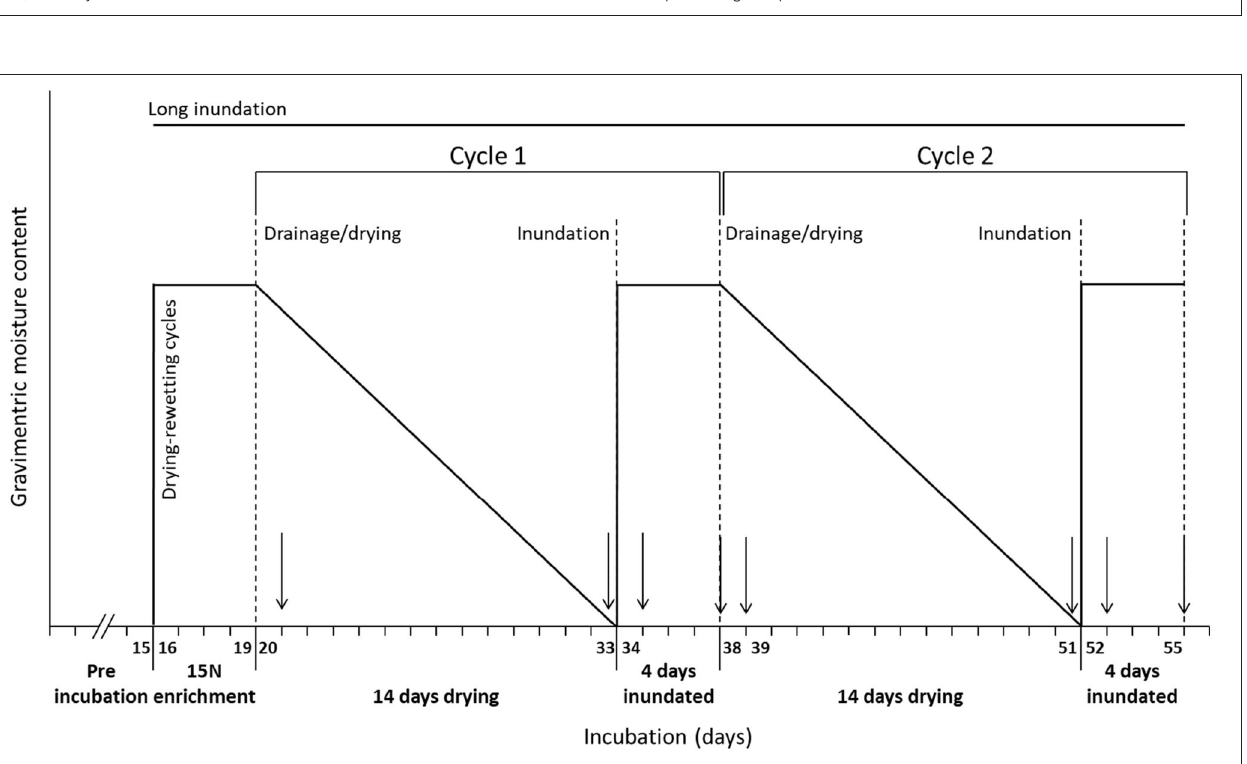
FIGURE 1 | Mesocosm apparatus. Each mesocosms consisted of one fixed part and one removable part. The fixed part consisted of a cylinder (h = 485mm, outer/inner d = 150/142mm; A) attached to an open plate at the top (d = 210mm, t = 20mm; B) and to a perforated plate at the bottom (d = 210mm, t = 12mm; C). Plates B and C had an indentation fitted with a rubber gasket, to ensure that all 3 parts were sealed tightly. The removable part consisted of 2 plates, a top plate and a bottom plate (d = 210mm, s = 8mm, D and E, respectively). Plates D and E were fitted with a rubber gasket, to ensure that all parts (A–D) were sealed tightly during deployment for the gas measurements. Plate D was equipped with the gas sampling apparatus, and was attached to plate B during gas sampling. Plate E was secured to plate C and was removed when the test mesocosms needed to be drained. All mesocosms parts were attached together with lengthwise bolts, screws, nuts, butterfly nuts and washers. The mesocosms were covered with a solid black liner to prevent light exposure.